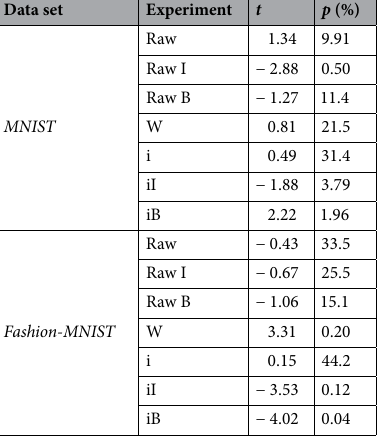
Table 2. Accuracy t-test for ‘ small world 177 is better than G ( n , p ) 177 ’. I—iterative pruning, B—bio pruning; W—winning ticket, i—structure implantation.